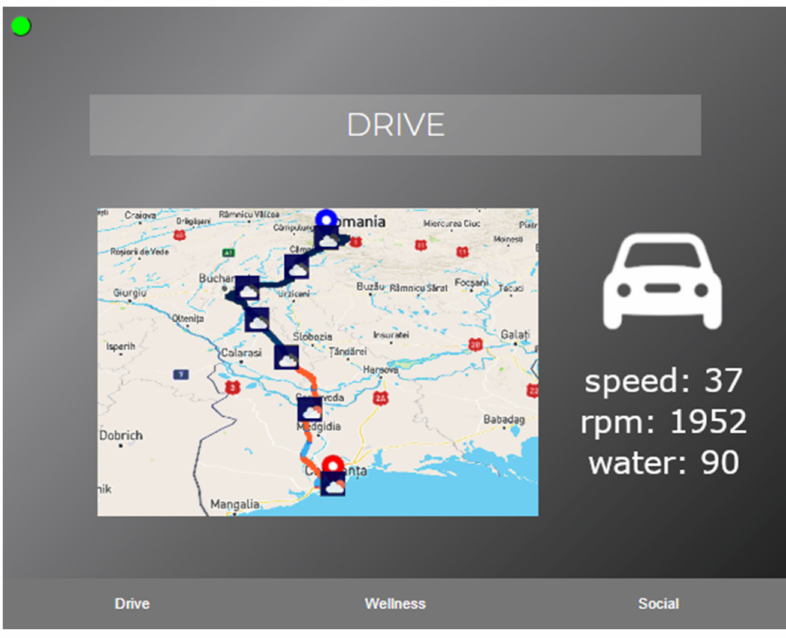
Figure 3. The Drive panel